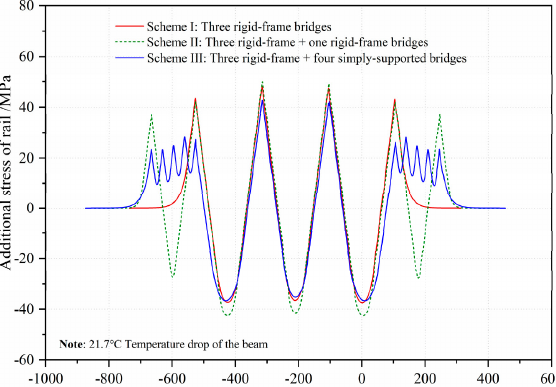
Figure 18. Additional expansion forces of the rail for three different schemes.